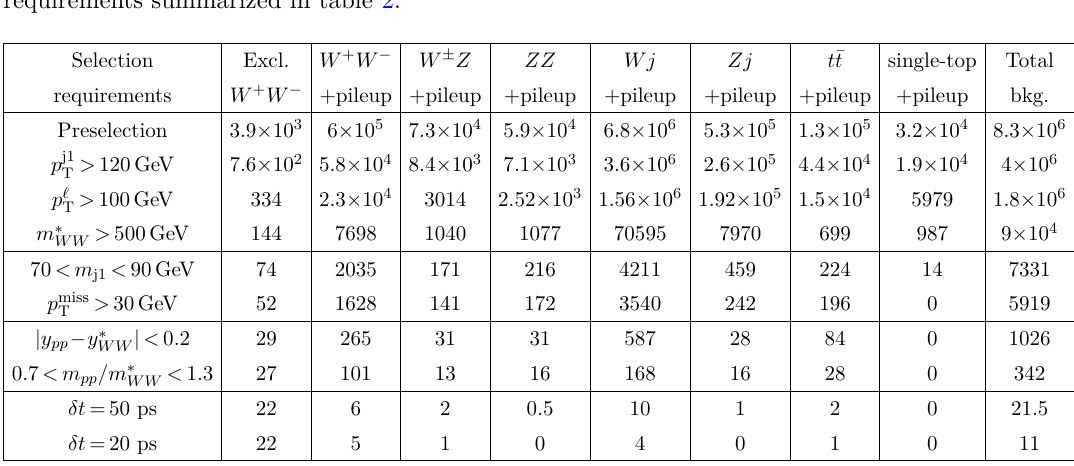
Figure 6 . Rapidity difference y pp − y ∗ (left) and mass ratio m pp /m ∗ (right) distributions WW WW for semi-leptonic decays of SM exclusive W + W − events (black full line) and pileup background (red dashed line) normalized to unity, after preselection requirements, and lepton jet kinematic requirements summarized in table 2.